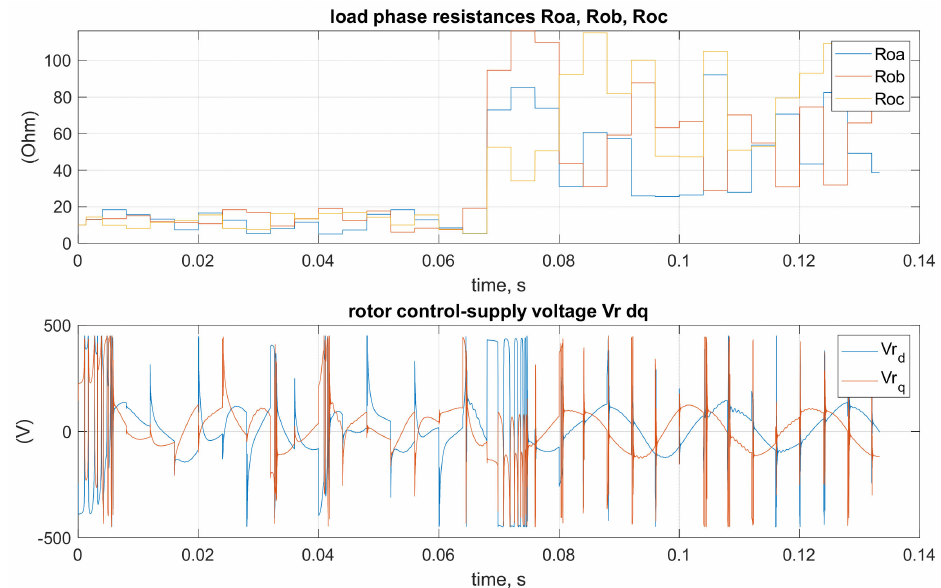
Figure 11. The rotor control voltage V r in the dq coordinate system against the load phase